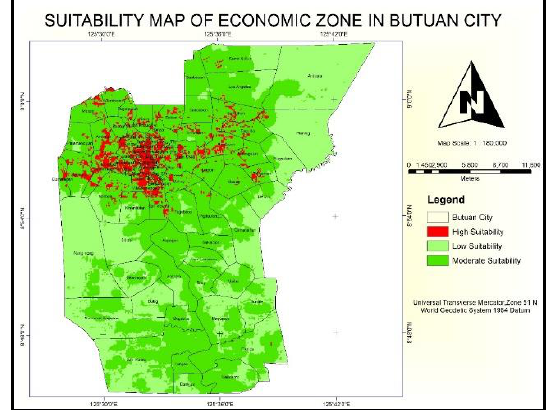
Figure 2. The suitability map for ecozone development